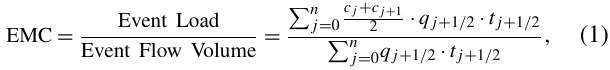
that cease to flow in dry